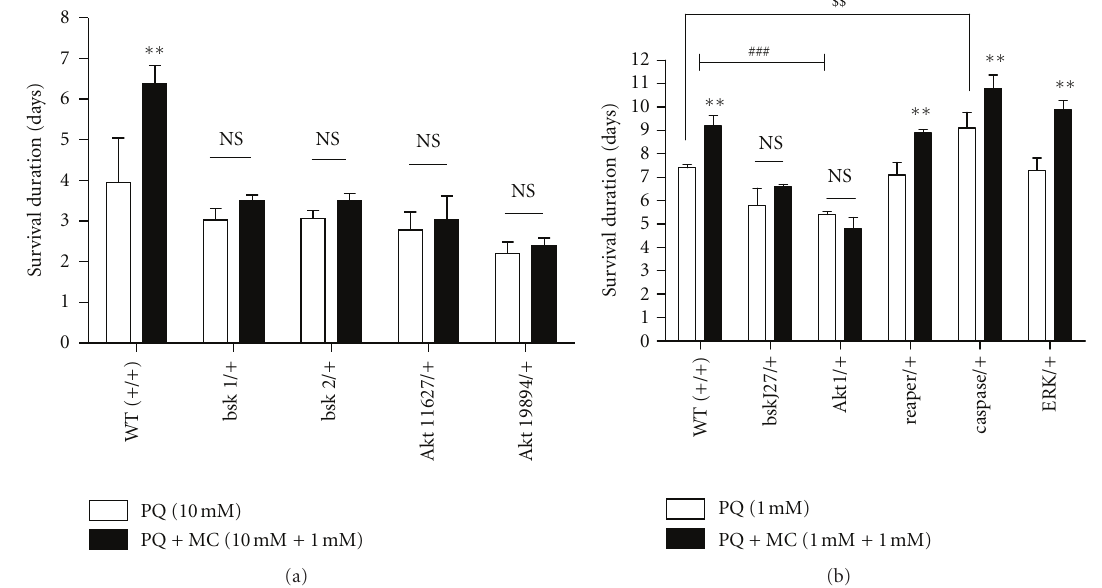
Figure 7: PQ and MC e ff ects on viability are modified by components of stress response pathways. (a) E ff ect of bsk and Akt loss-of-function mutant alleles on PQ and MQ e ff ects on survival. Treatment with 1mM MC failed to improve the survival of bsk and Akt loss-of-function mutants fed 10mM PQ. n = 120 and each data point represents at least three independent replications of 40 flies for each.genotype. (b) E ff ect of 1mM PQ and 1mM MC on loss-of-function mutants of signaling pathways, JNK, Akt, reaper, caspase, and ERK. rolled (ERK), reaper and caspase mutants showed an extension of life span with MC treatment, while the survival of JNK and Akt mutants was unmodified in the presence of MC. ∗∗ = P < 0 . 005 represents significant di ff erence between PQ and PQ with MC groups. ## = P < 0 . 005 and shows a significant di ff erence between PQ-fed wild type and PQ-fed bsk and Akt loss-of-function mutants. NS = not significant. $$ = P < 0 . 005 represents significant di ff erence between PQ-fed wild type and PQ-fed caspase loss-of–function mutant. Error bars represent standard error of the mean. n = 180 and each data point represents at least three independent replications of 50–60 flies